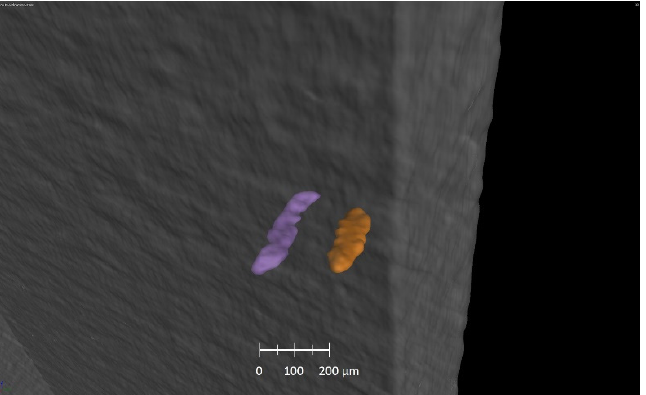
Figure 11. Failure-critical inner defects, purple and orange, of an STA heat-treated EB-PBF-manu-